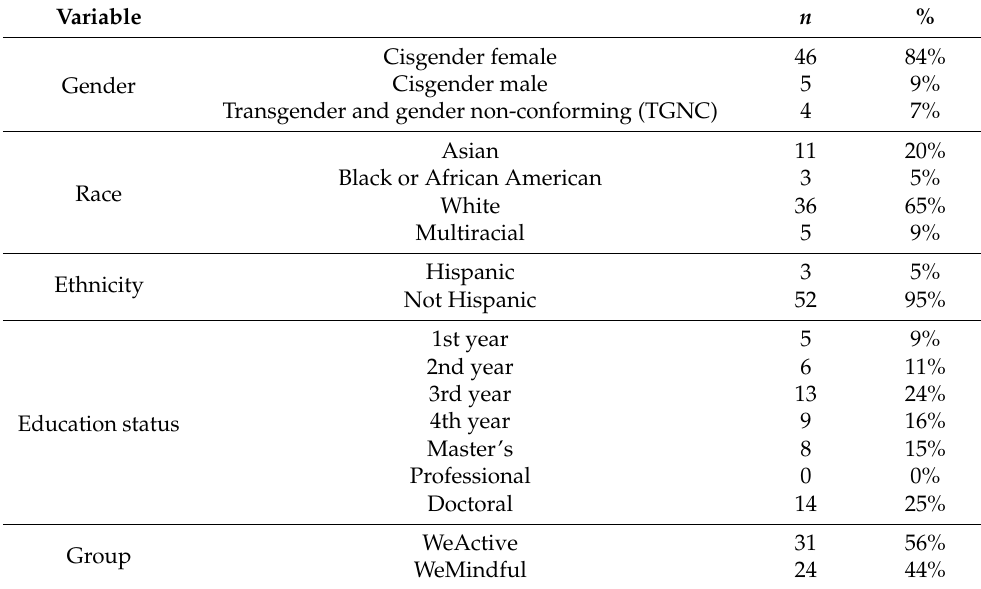
Table 1. Demographic data of total participant